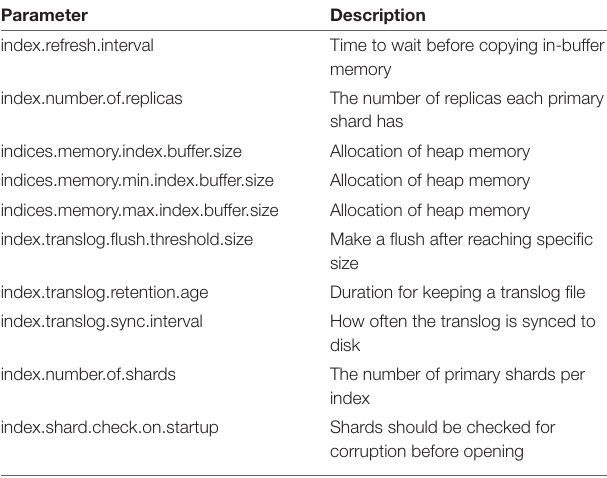
FIGURE 1 | Elasticsearch performance